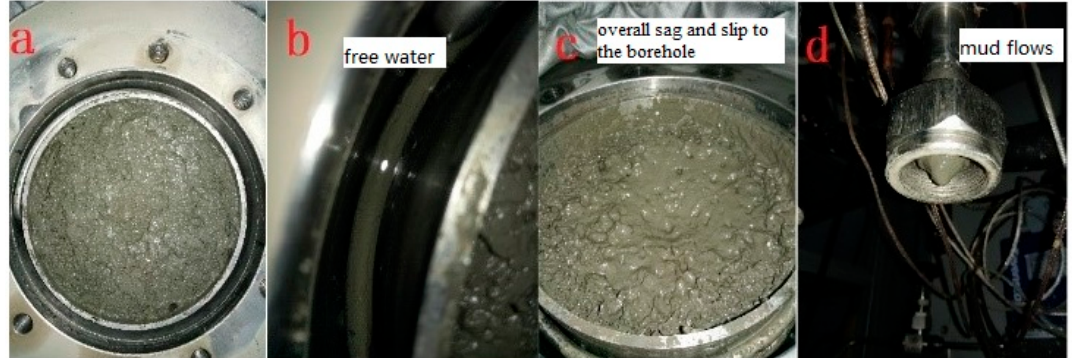
Figure 6. ( a ) The reservoir after water substitution; ( b ) free water between the reactor wall and sediments chamber wall; ( c ) the reservoir after mining; ( d ) the blocked connection pipe (wellbore) of the gas–liquid–solid separator.